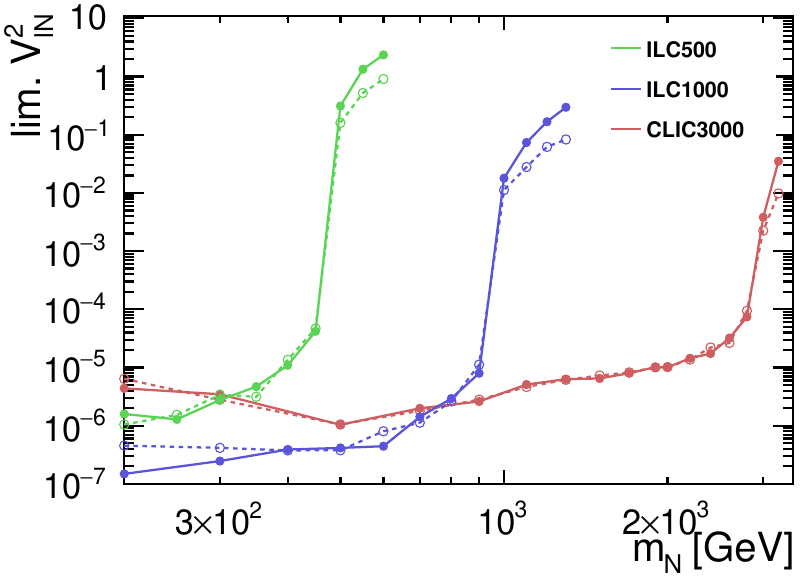
Figure 9. Comparison between results for Majorana (dashed line) and Dirac (solid line) neutrinos for different collider scenarios: green for ILC500, blue for ILC1000 and red for CLIC3000